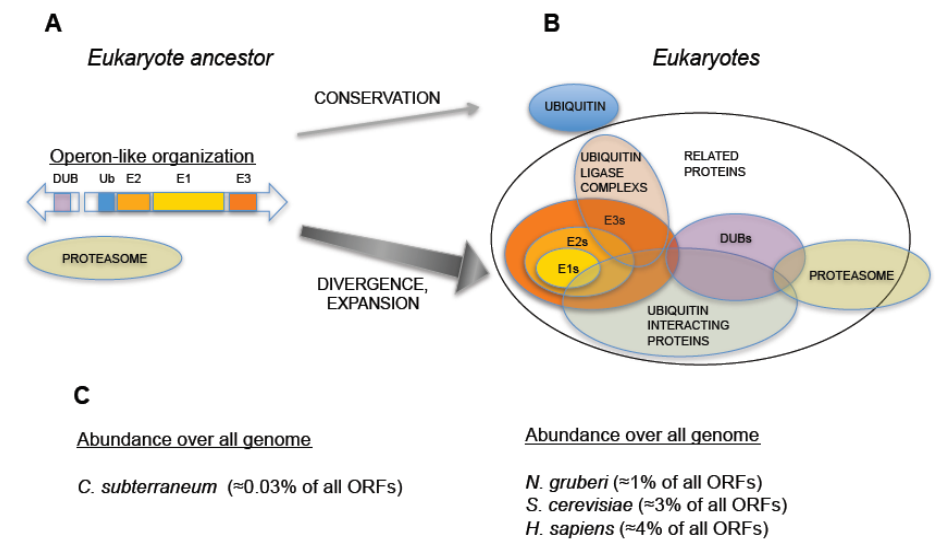
Figure 2. Hypothetical evolution of the Ubiquitin-Proteasome System from an operon-like cluster. ( A ) Schematic representation of an operon-like cluster, based on C. subterraneum (11), in which the minimal representation of the factors required for ubiquitin-signaling is found in this type of genetic arrangement. ( B ) Representation of an expanded UPS, as found in eukaryotes, which includes groups of factors involved in UPS and their interactions. Central arrows indicate distinct behaviors in UPS evolution: while ubiquitin was conserved, the rest of ubiquitin signaling genes underwent an expansive process. ( C ) Percentage of ubiquitin and UPS related genes (including ubiquitin-like related factors) with respect to all annotated open reading frames in the genomes of: C. subterraneum (as a hypothetical model of eukaryote ancestor), the protist N. gruberi , the yeast S. cerevisiae and H. sapiens . A dramatic increase in the abundance of UPS genes is observed in